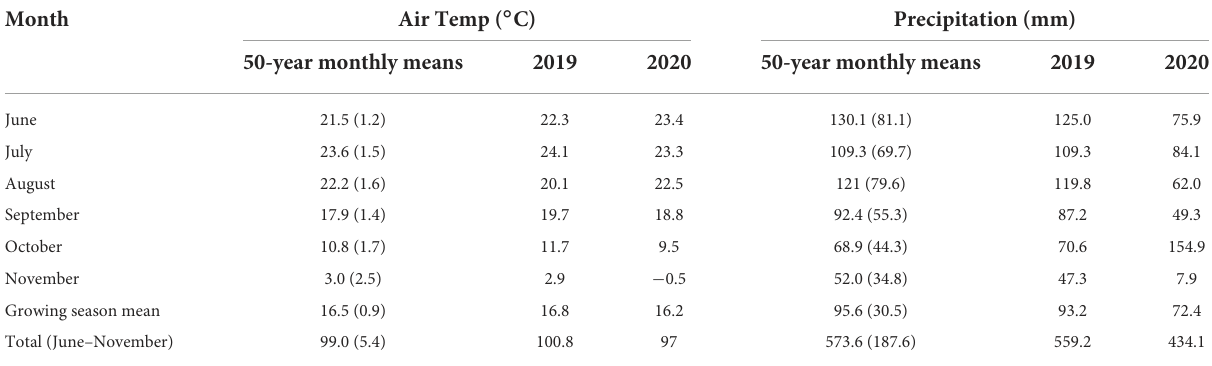
TABLE 1 Monthly mean air temperature and rainfall at the research site near Ames,